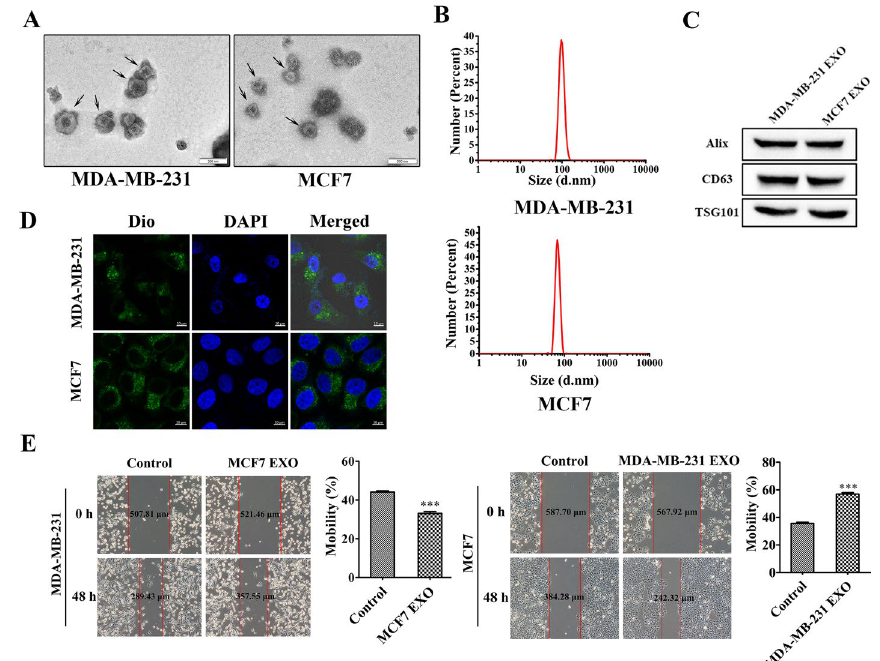
Fig. 1 Exosomes from highly invasive breast cancers are more likely to promote cancer cell migration than less invasive ones. A Transmission electron microscopy of exosomes extracted from MDA-MB-231 and MCF7 breast cancer cell lines. Scale bar, 200 nm. B Particle size distribution of isolated exosomes. C Western blot analysis of Alix, TSG101 and CD63, marker proteins of exosomes isolated from MDA-MB-231 and MCF7 cells. D Exosomes were labelled using Dio stain and co-incubated with MCF7 and MDA-MB-231 cells for 3 h. Scale bar, 10 μm. E Wound healing experiments with MCF7 and MDA-MB-231 cells treated with MDA-MB-231 exosomes and MCF7 exosomes, respectively. Data are presented as mean *** p <